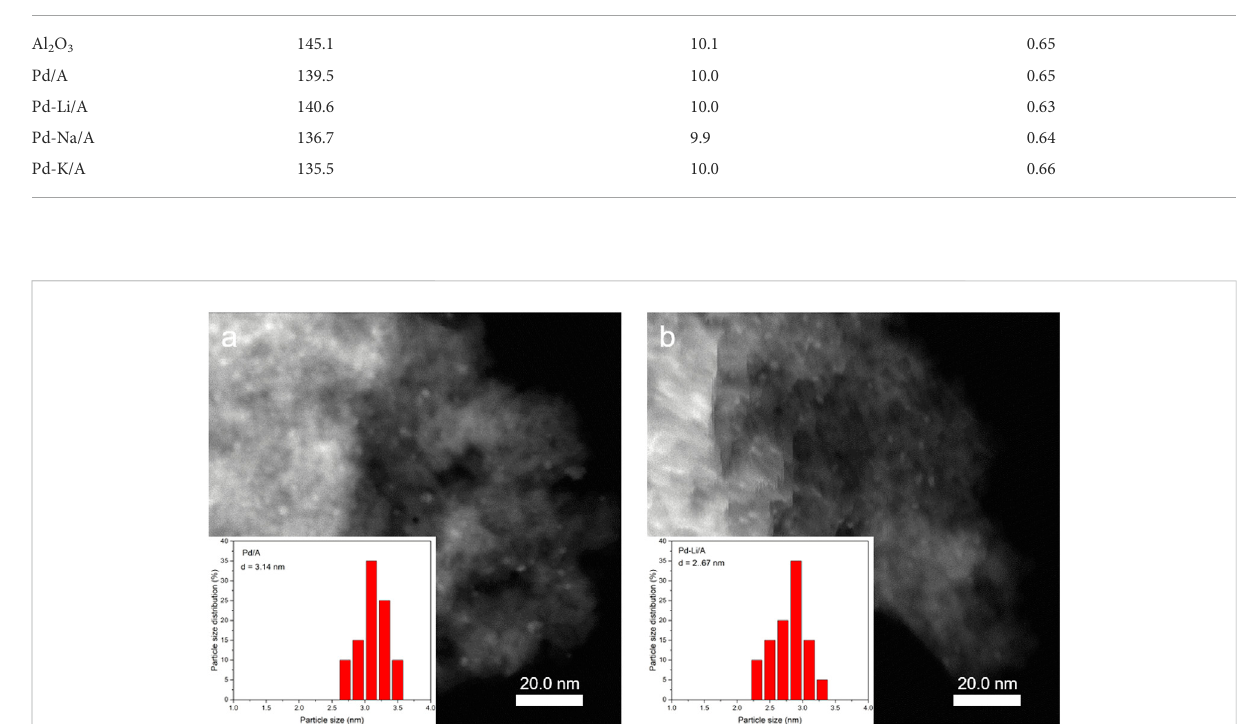
TABLE 1 Pore structure information of Al 2 O 3 support, Pd/A, and alkali metal-modi fi ed Pd catalysts. Sample